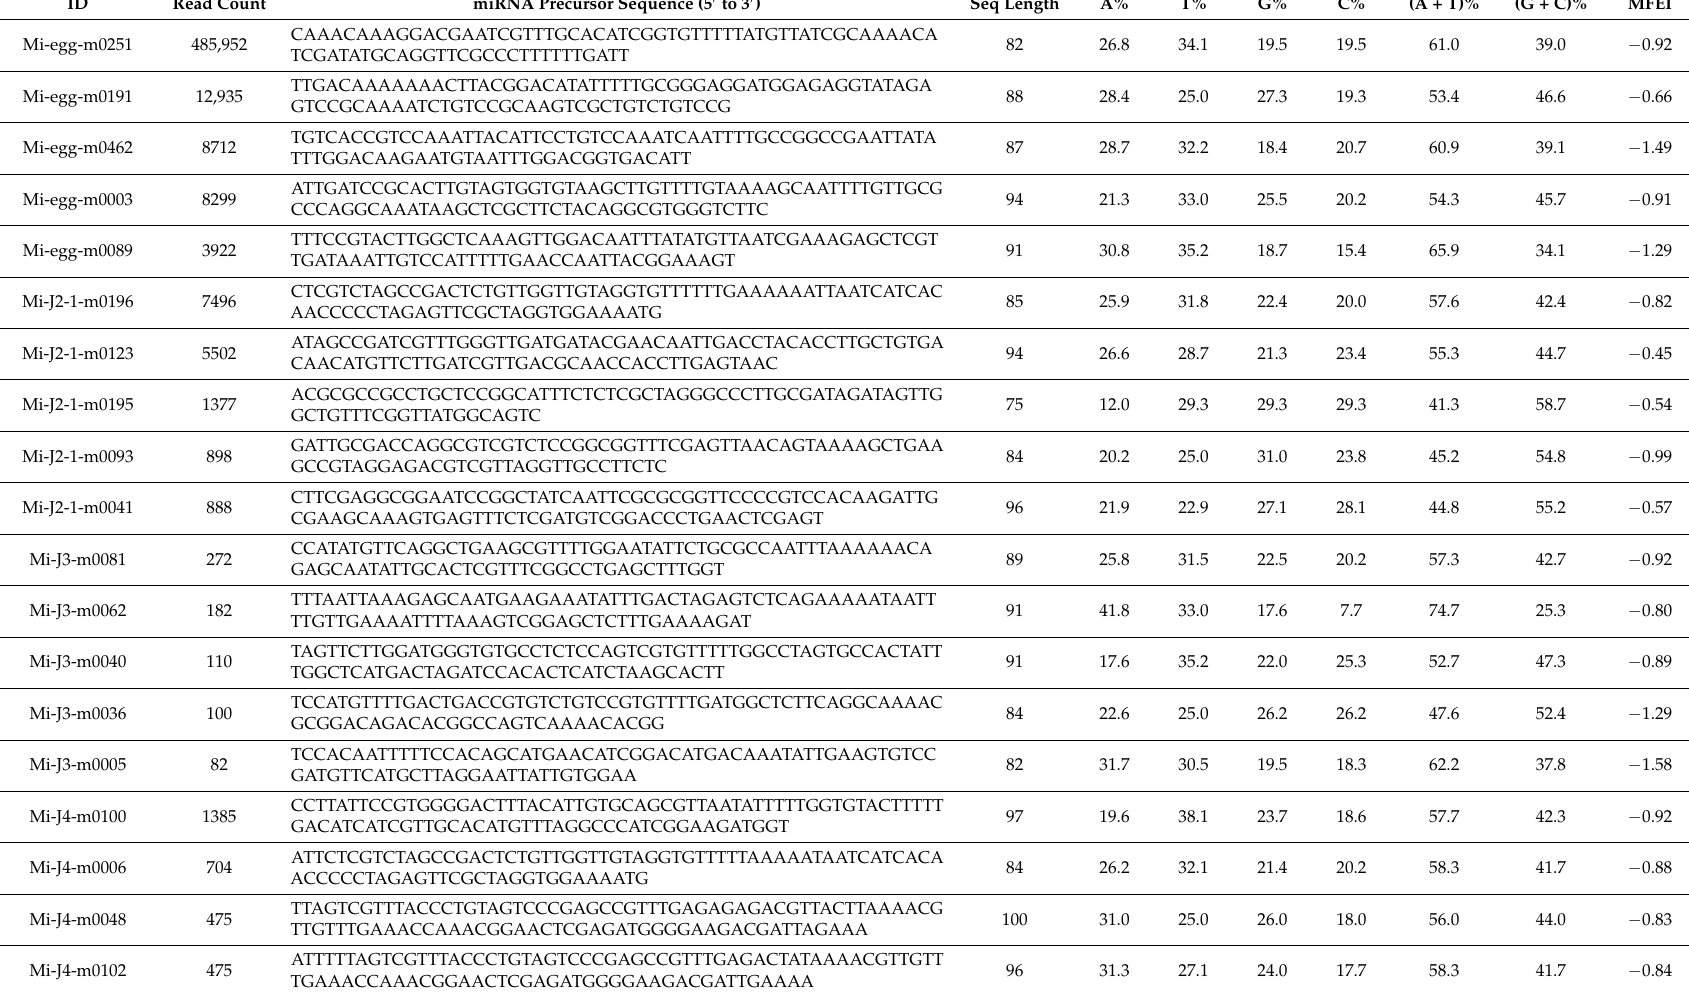
Table 4. Novel miRNA identification using MIREAP to distinguish pre miRNA among unannotated